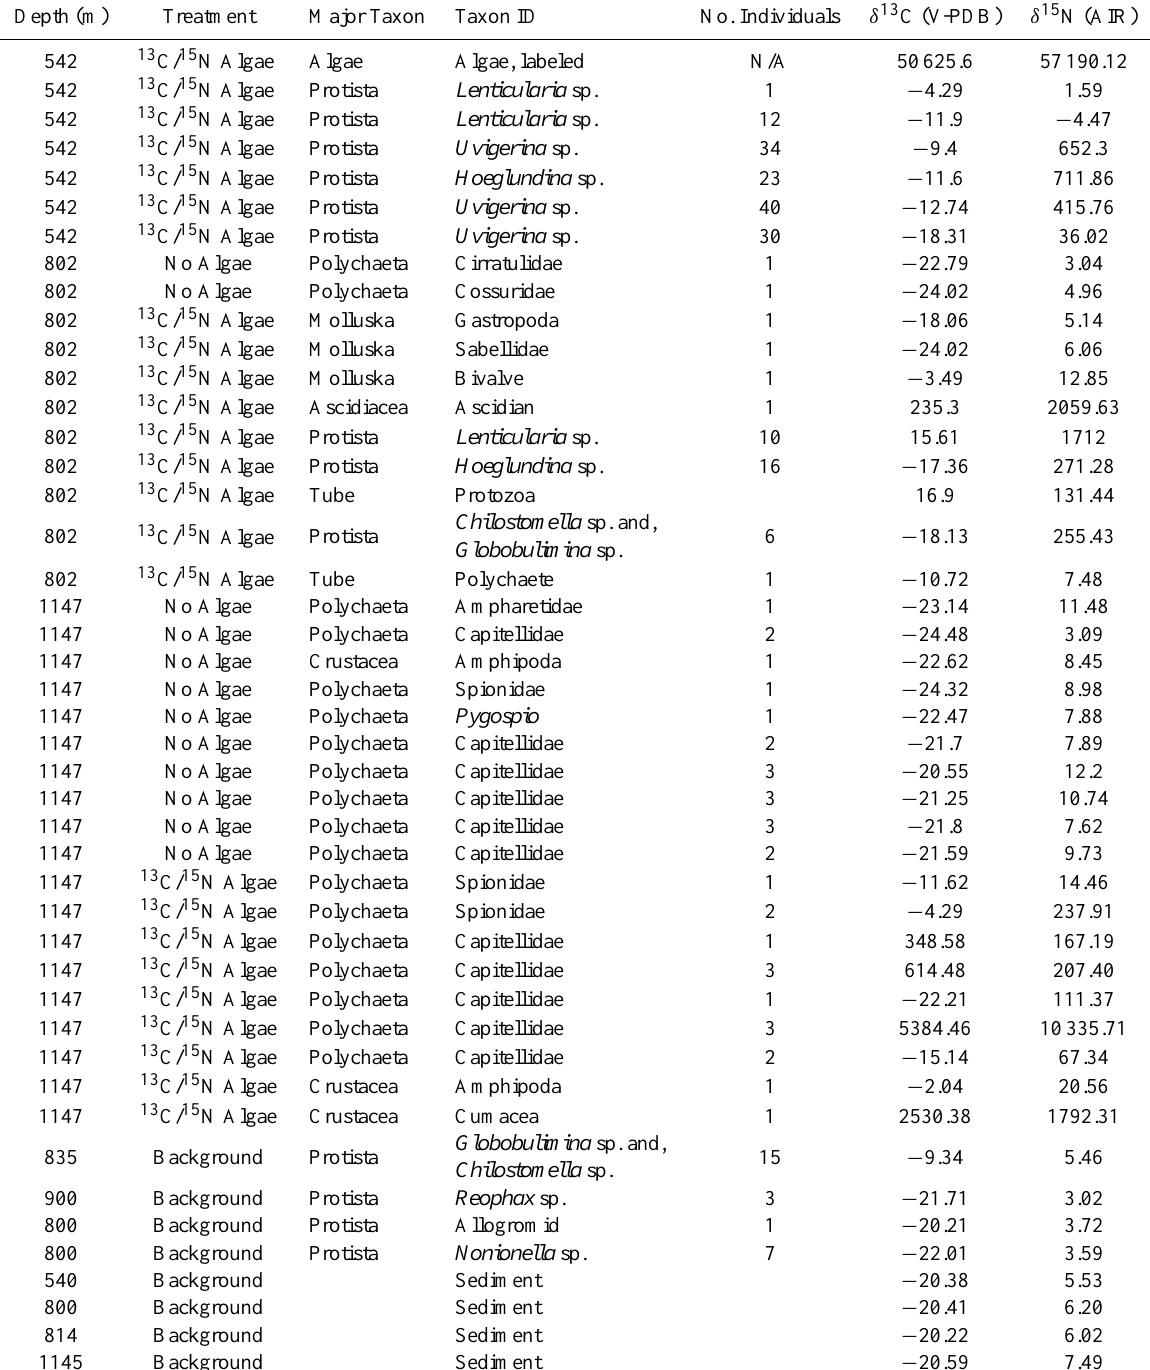
Table 5. Carbon and nitrogen stable isotopic signatures for colonizers of trays with and without labeled phytodetritus (algae) added. Back- ground data are also given for sediments and protistans. Background data for macrofauna are given in Hunter et al. (2012) (Fig. 4). Depth